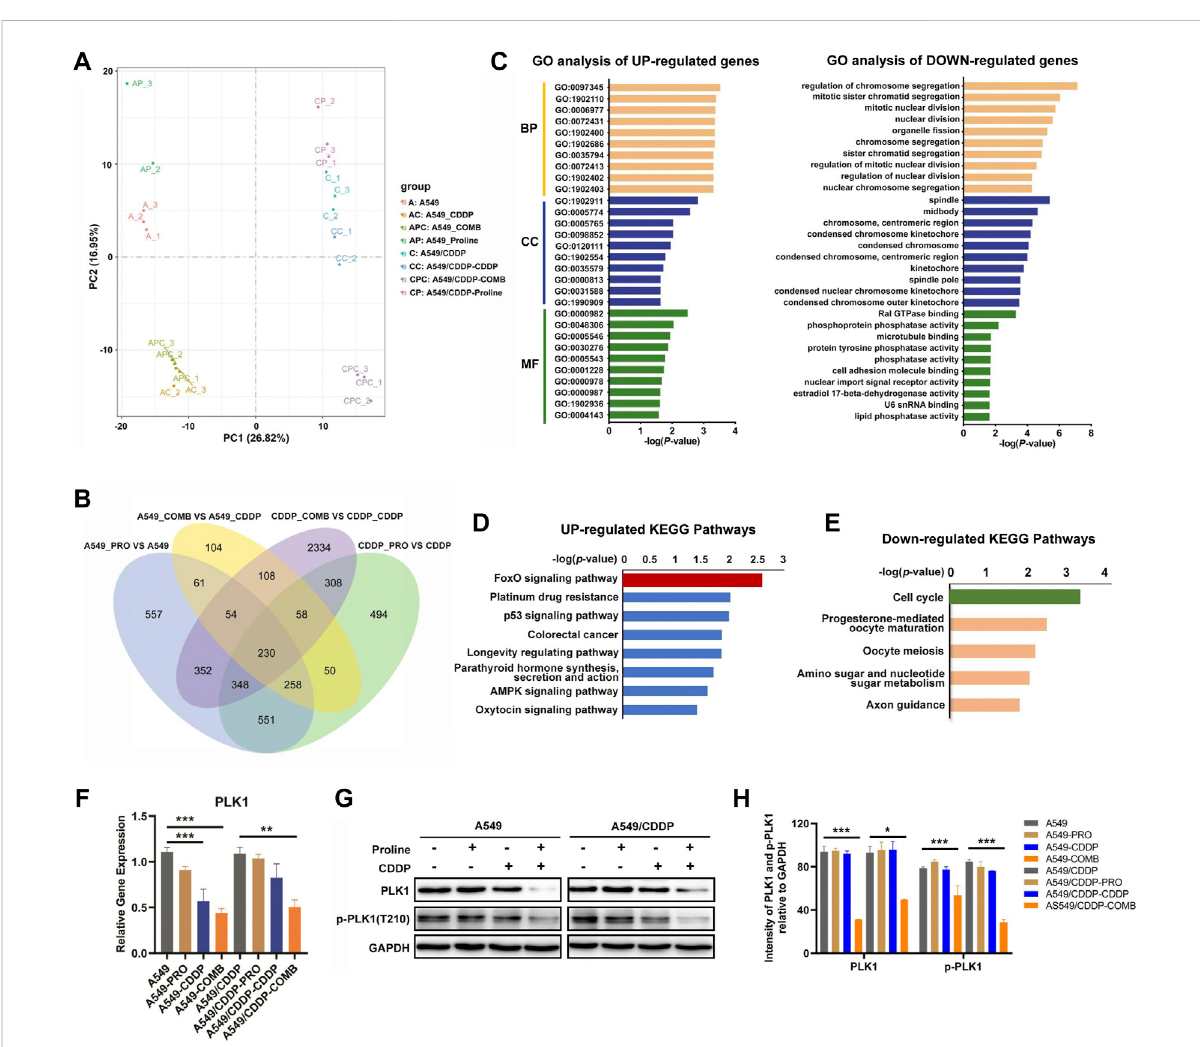
FIGURE 3 Transcriptomicpro fi lingrevealsthealterationofgenetranscriptionlevelsinA549andA549/CDDPcellsupon20 mMproline,10 μ MCDDP,and their combination treatment. (A) PCA analysis of transcriptomic pro fi les obtained from A549 and A549/CDDP cells exposed to different treatments. Each dot represents abiological repeat. (B) Venn plotshows the overlap of signi fi cantly differential genes of four groups (group 1/2/3/4)in A549 and A549/CDDP cells. (C) GO analysis was performed on 108 signi fi cantly differential genes corresponding to (B) . (D,E) KEGG enrichment pathway analysis of upregulated and downregulated mRNAs in (B) . (F) Relative transcription levels of PLK1 in A549 and A549/CDDP cells were detected by qRT-PCR. (G) Effects of proline, CDDP, and their combination on protein levels of p-PLK1 and PLK1. (H) The bands in (G) were quanti fi ed and presentedasthemean±SEMofthreeindependentexperiments.Statisticalsigni fi cancewasdeterminedbyatwo-tailed,pairedStudent ’ st-test.* p < 0.05, ** p < 0.01, *** p <